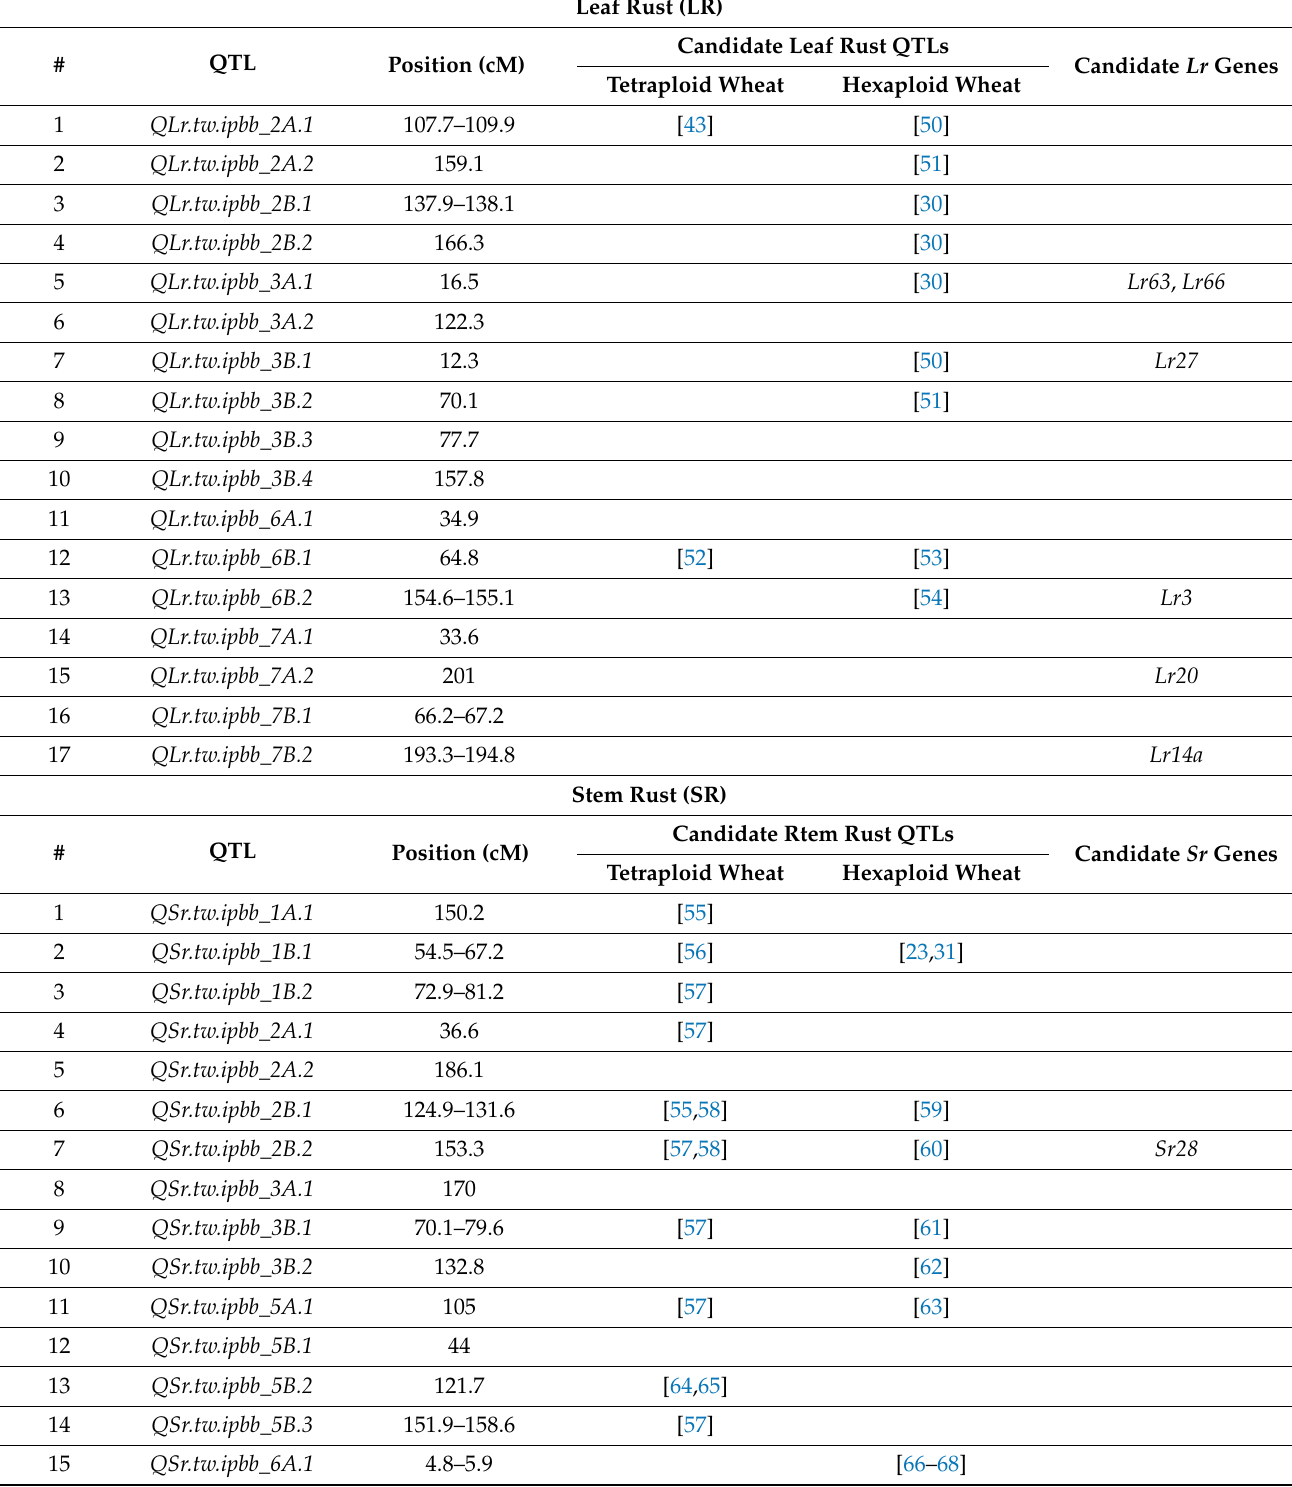
Table 9. Comparison of leaf rust (LR) and stem rust (SR) resistance QTLs with possible candidate QTLs from the